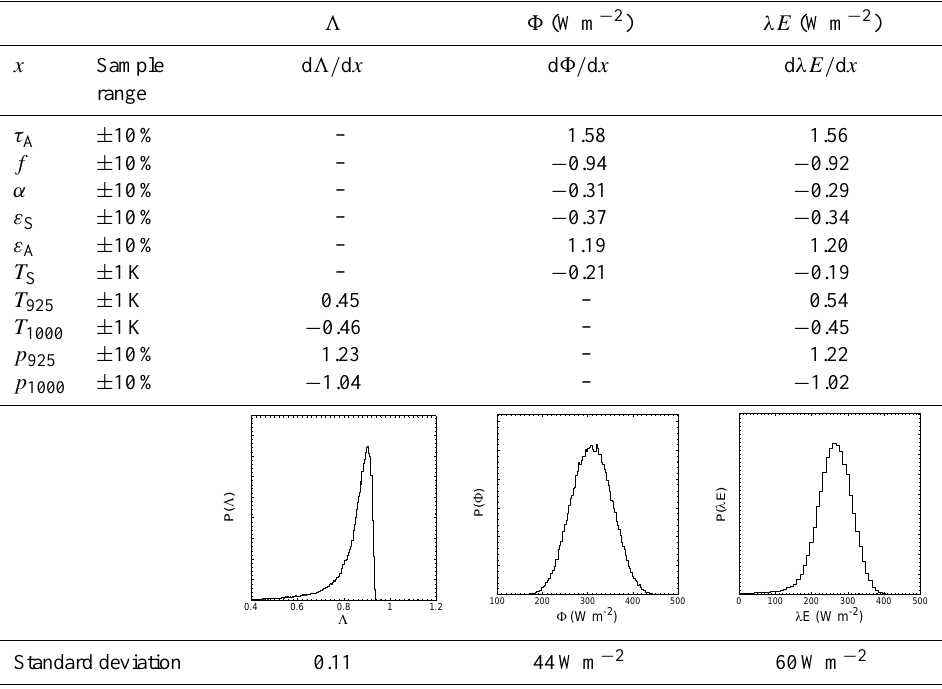
τ A = atmospheric transmissivity; f = cloud cover fraction; α = surface albedo; ε S = surface emissivity; ε A = 800